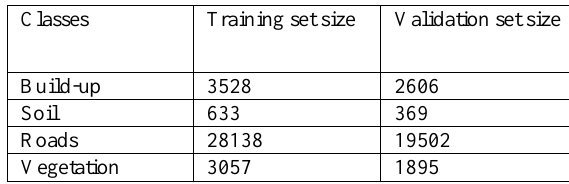
Table 1: The number of training and testing data for image